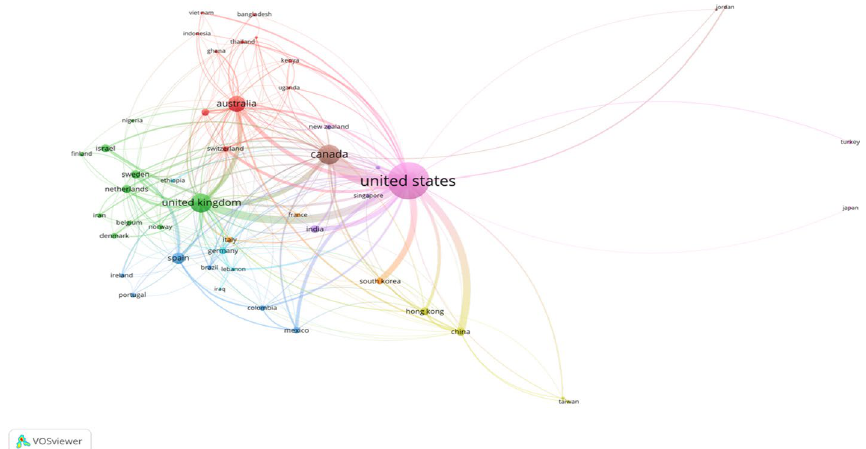
Fig. 5 Visualisation map of co-authorships links by